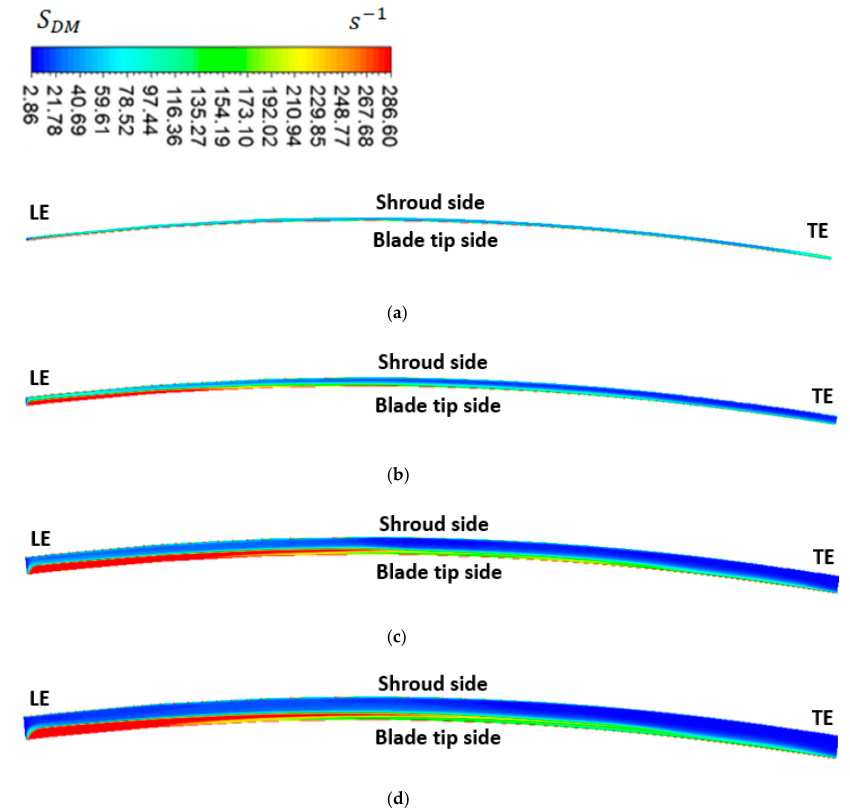
Figure 20. Distribution of S DM (reflecting the turbulent entropy generate rate) on the selected plane along the blade chord direction in a varying tip gap at φ = 0.354 (( a ) h = 0.1% span; ( b ) h = 0.3% span; ( c ) h = 0.6% span; and ( d ) h = 0.8% span).